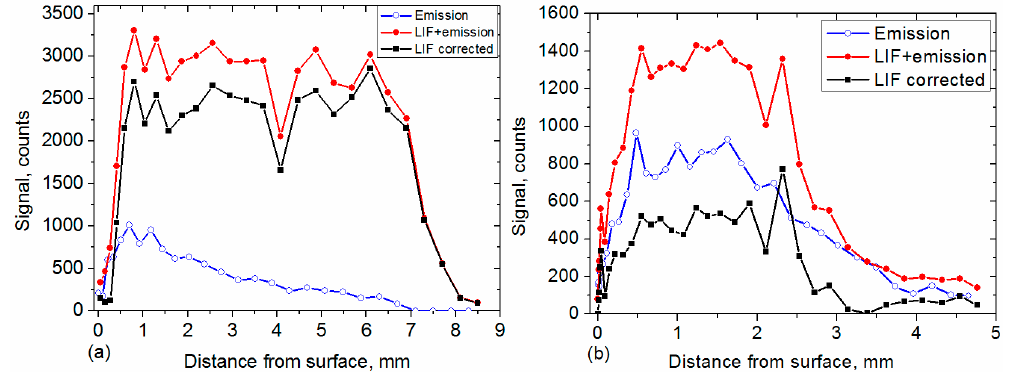
Figure 9. Comparison between emission ( ○ ) and LIF + emission ( ● ) signals originating from ( a ) Particle 3 and ( b ) Particle 5 of Figure 5, versus distance above the burning propellant sample (Al/AP/HTPB) at 1.2 MPa. The LIF signal ( ■ ) is obtained after subtracting emission background and is corrected for the spatial non-uniformity of the laser sheet.